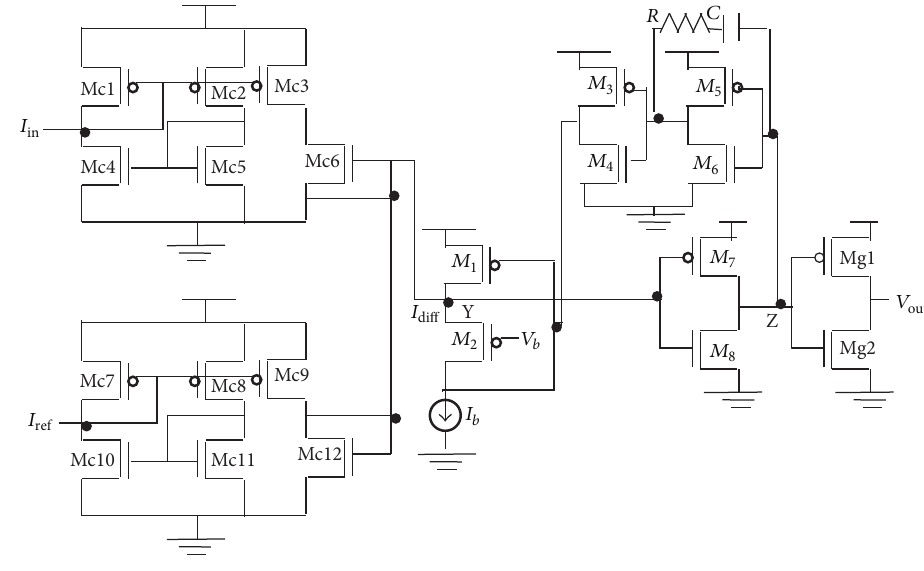
Figure 3: Proposed current